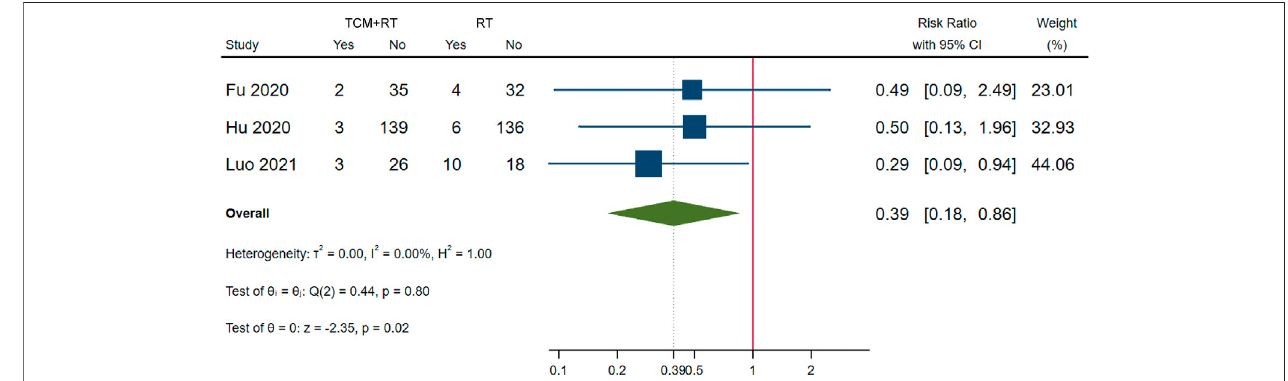
FIGURE 5 | Forest plot of clinical deterioration.